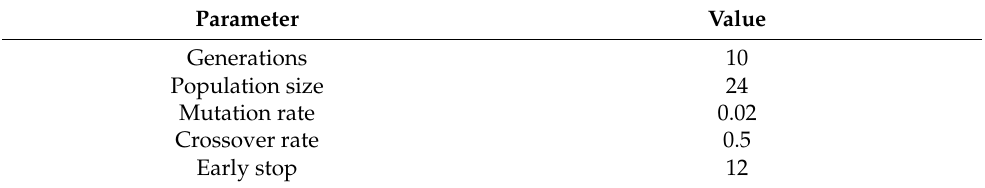
Table 5. Parameter settings of the GA used in this paper.